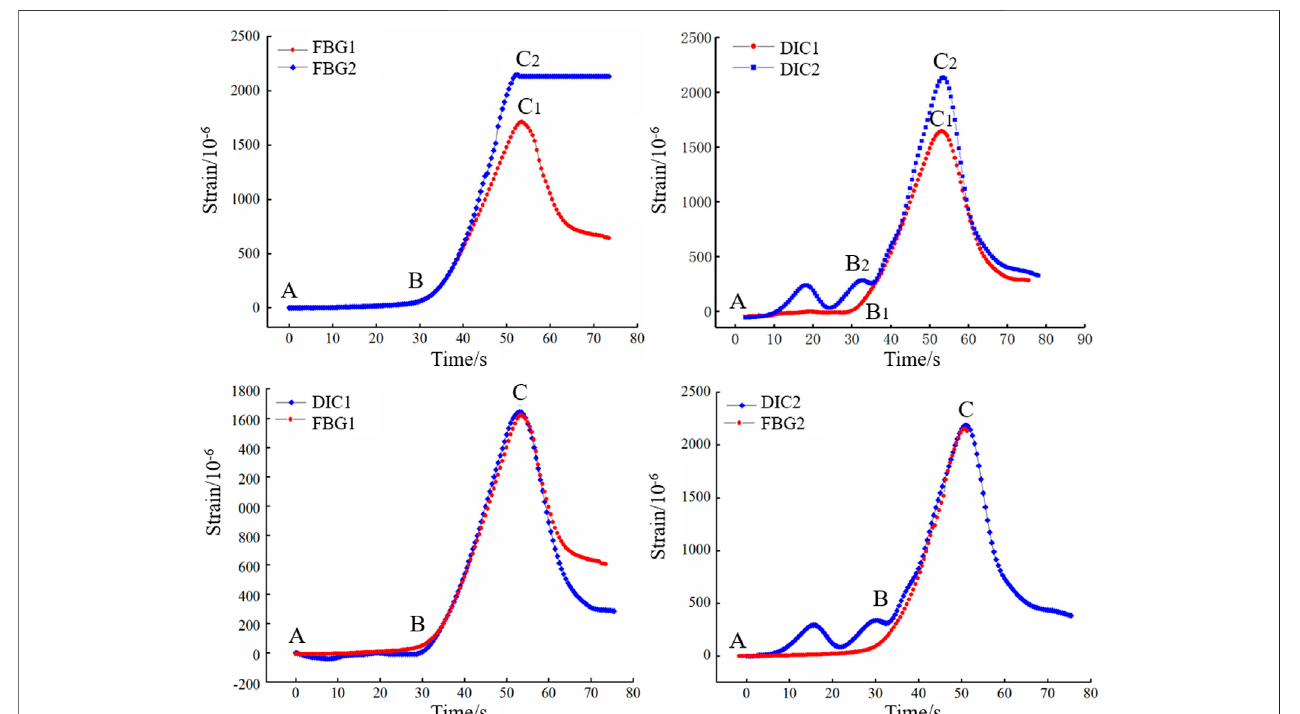
FIGURE 5 | Comparison of strain distribution measured by DIC and FBG.